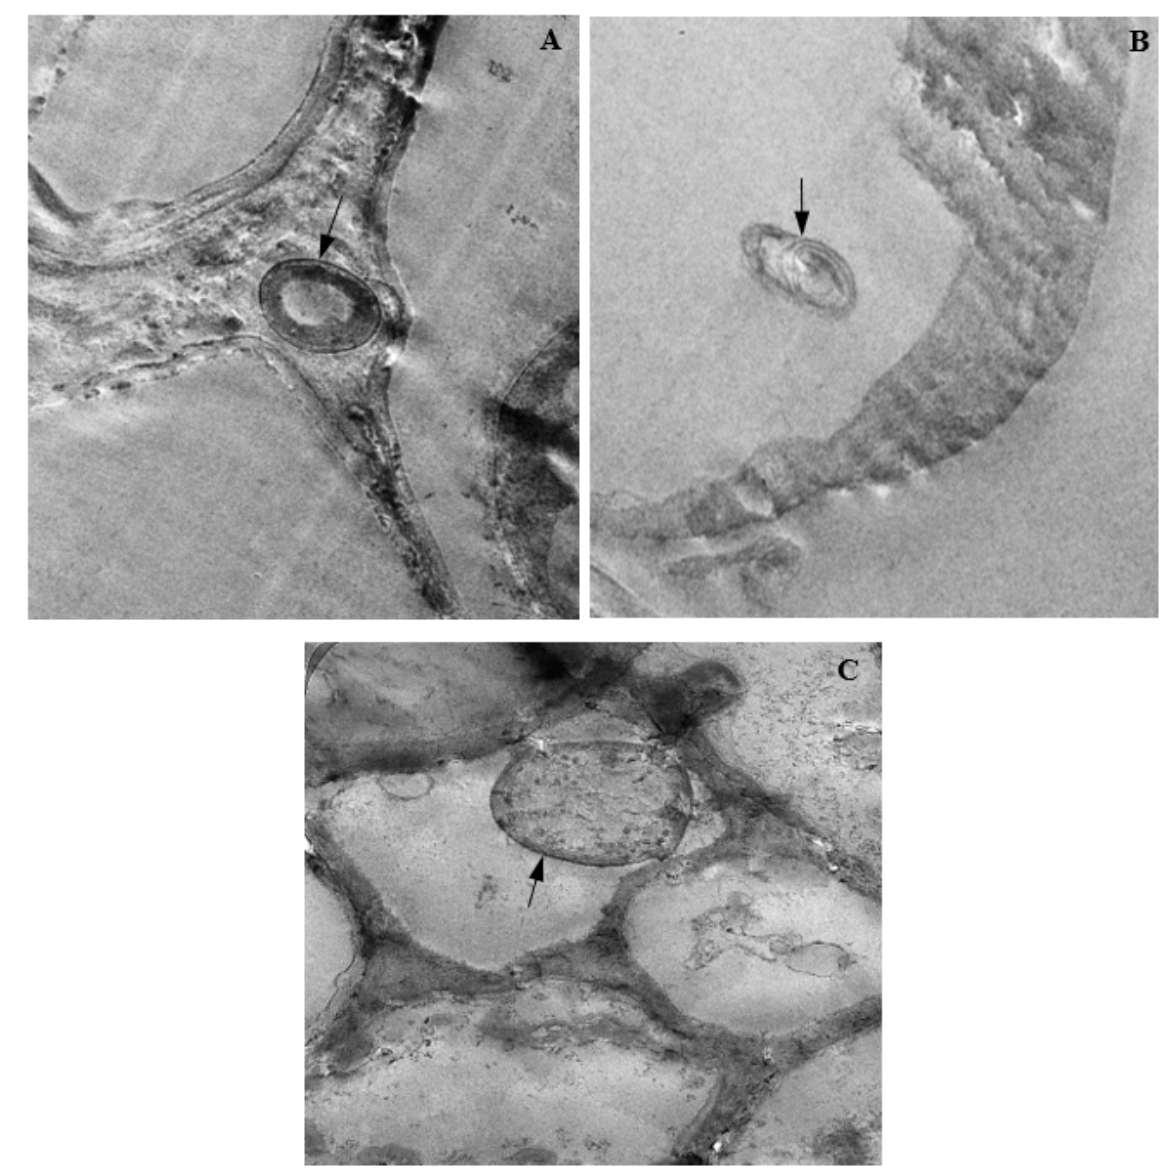
Figure 13. Transmission electron micrographs showing e ndophytic colonization of corn tissues by Fusarium verticillioides . The black arrows indicate the presence of hyphae in infected the ( A ) root intercellular space; ( B ) stem parenchyma; and ( C ) leaf